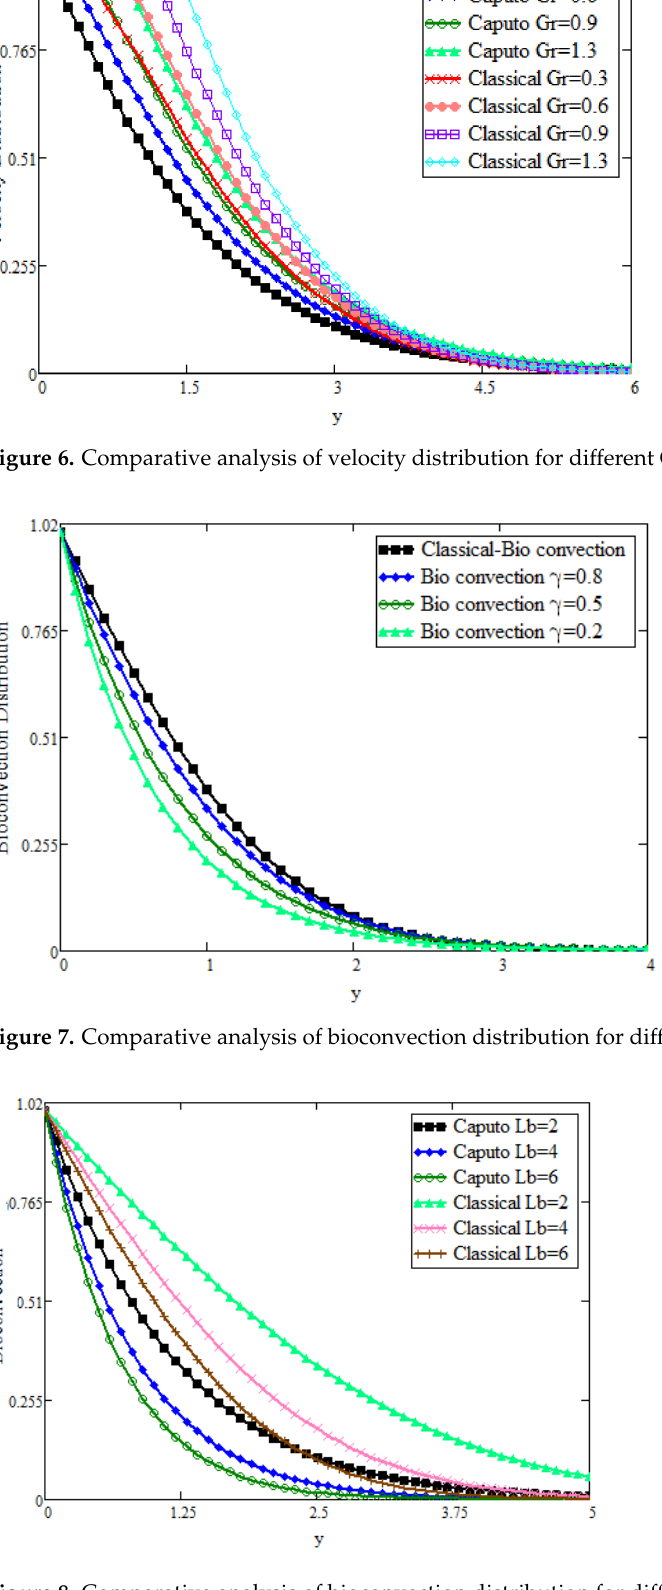
Figure 8. Comparative analysis of bioconvection distribution for different Lb